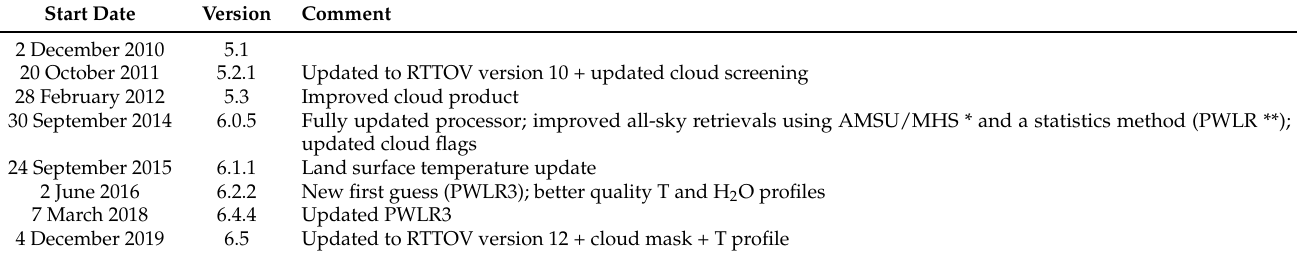
Table 1. EUMETSAT IASI operational level 2 retrieval versions and dates since 22 February 2011 [19,24]. Only the changes linked to the data we use (the surface temperature, the cloud fraction and/or the temperature and humidity profiles) are listed. * AMSU/MHS = Advanced Microwave Sounding Unit/Microwave Humidity Sounder; ** PWLR = piece-wise linear